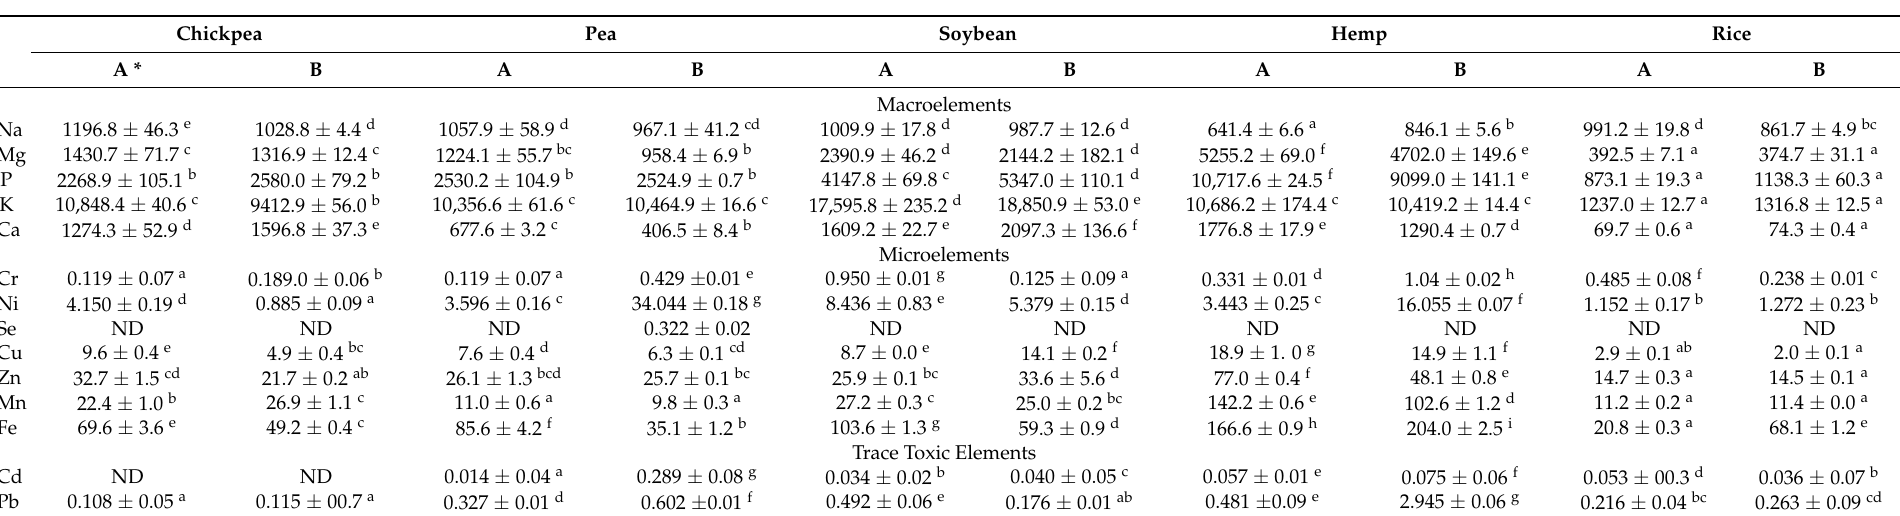
* A and B are different commercial brands. a–j: values followed by different superscripts in the same row are significantly different ( p < 0.05). Table 2. The mineral composition (mg/kg fresh weight) of different flours. Data presented as means ± standard deviation from triplicate